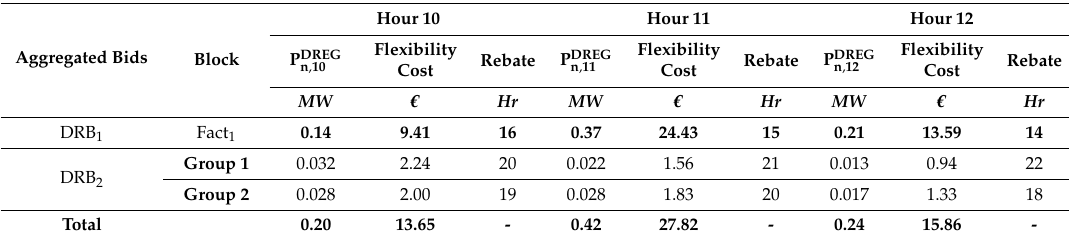
Figure 5. ( a ) Activated blocks in the aggregated industrial bid at hour 10; ( b ) Activated blocks in the aggregated residential bid at hour 10. Table 7. Flex-DLM results for the day-ahead operation.